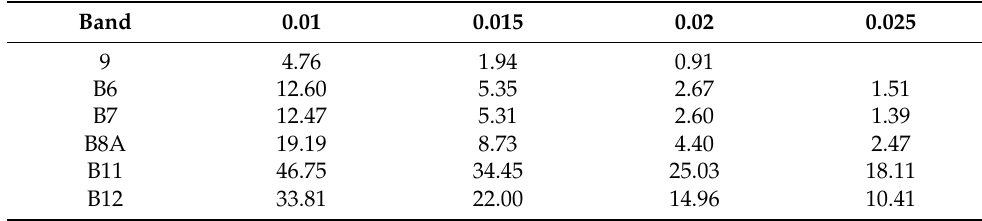
Table 5. Percentage of pixels beyond a given absolute error threshold (L2A).